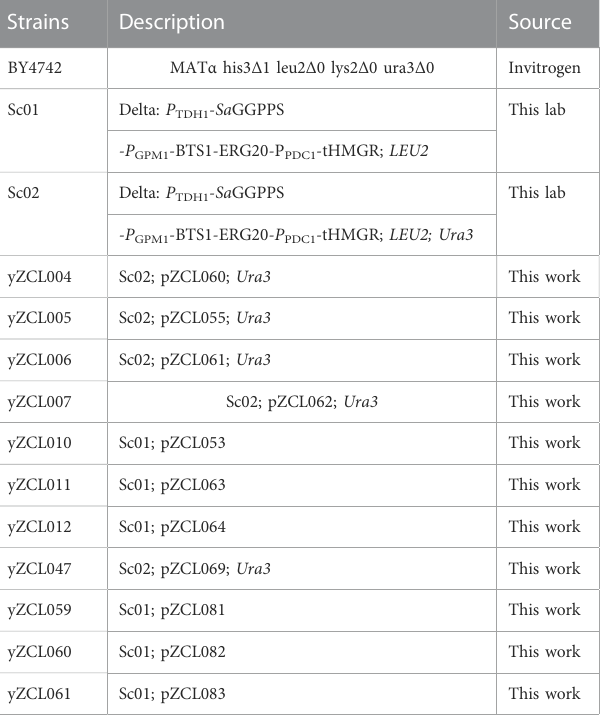
TABLE 1 Yeast strains used in this study.